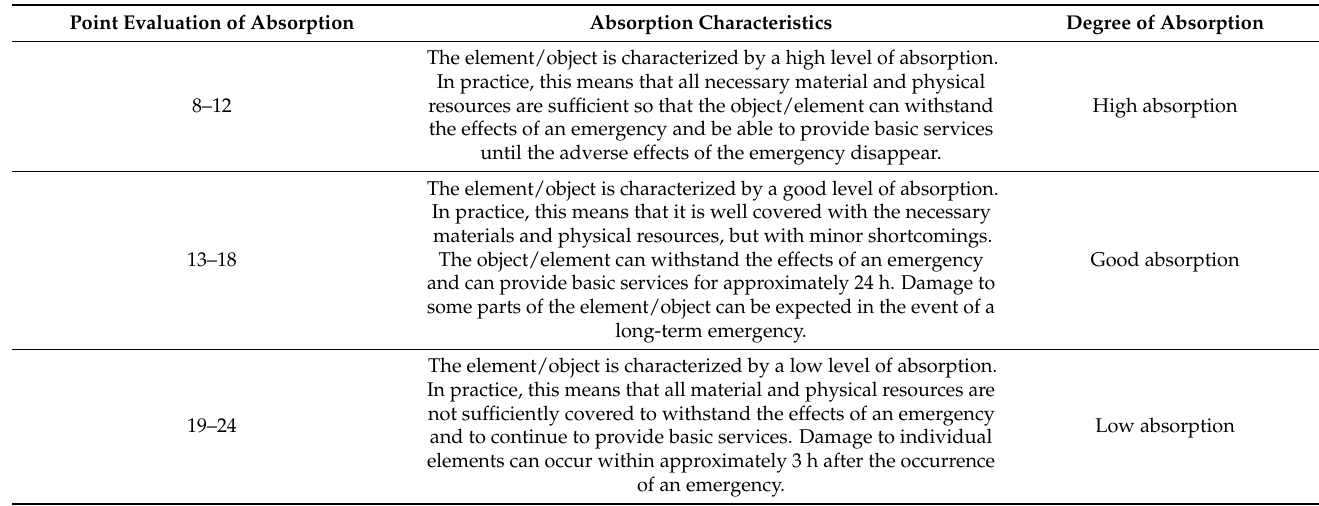
Table 4. Determination of the total level of absorption.